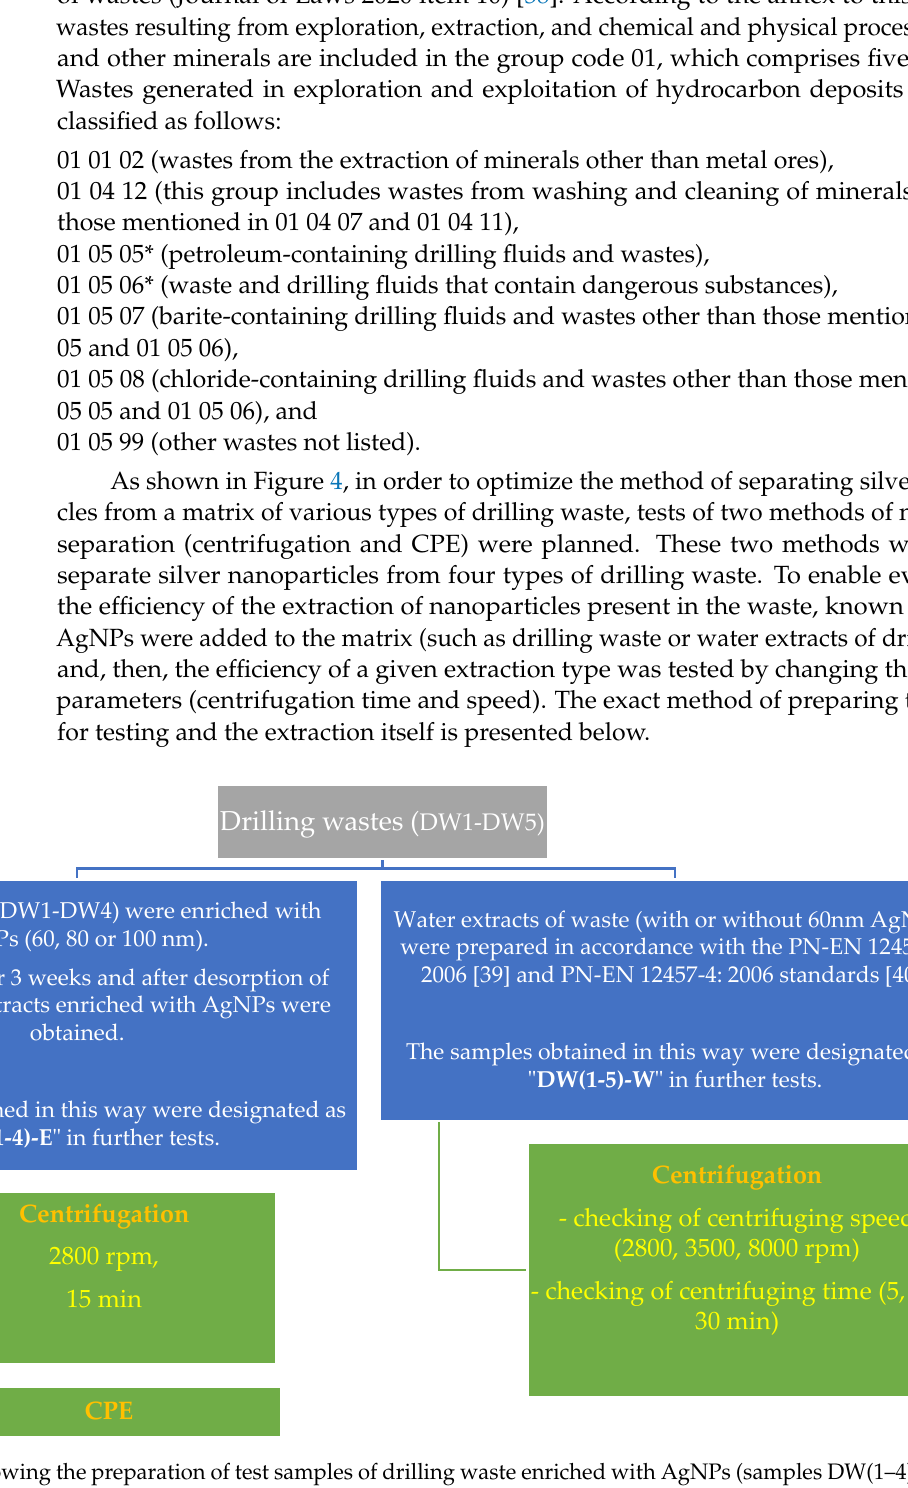
Figure 4. Diagram showing the preparation of test samples of drilling waste enriched with AgNPs (samples DW(1–4)-E) and water extracts of drilling waste (samples DW(1–5)-W). Methods and detailed parameters of AgNP separation used during the studies are also presented. Two research procedures were used with waste samples. The first involved enrichment of drilling waste with silver nanoparticles and desorption of nanoparticles (NPs) into an aqueous solution. At this stage, waste extracts enriched with AgNPs were obtained, and samples after this stage were labeled as DW(1-4)-E. The second stage of the research was to obtain water extracts of drilling waste, which were then enriched or not with AgNPs and subjected to further tests. Samples after this stage of research were labeled as DW(1 4)-W.